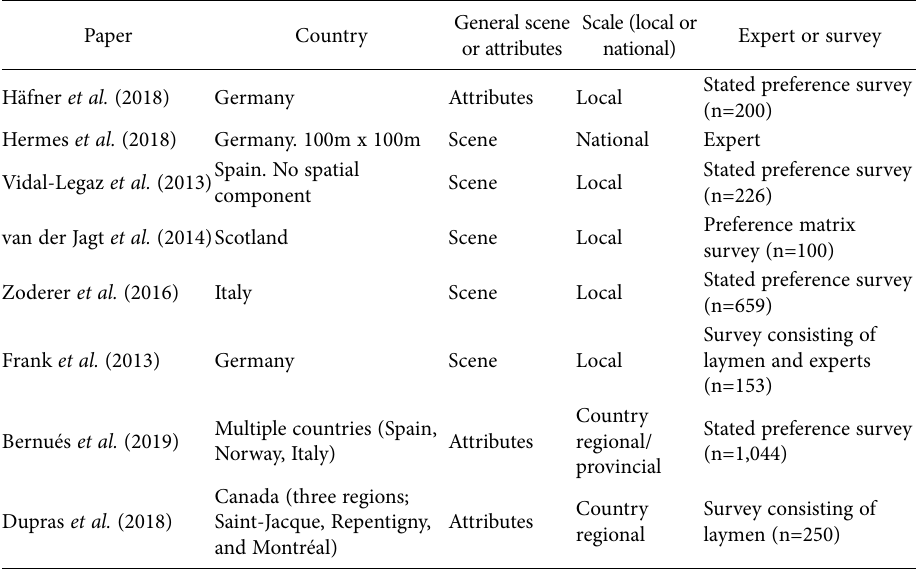
Table 1. Choice of Landscape Attribute in Recent Studies.